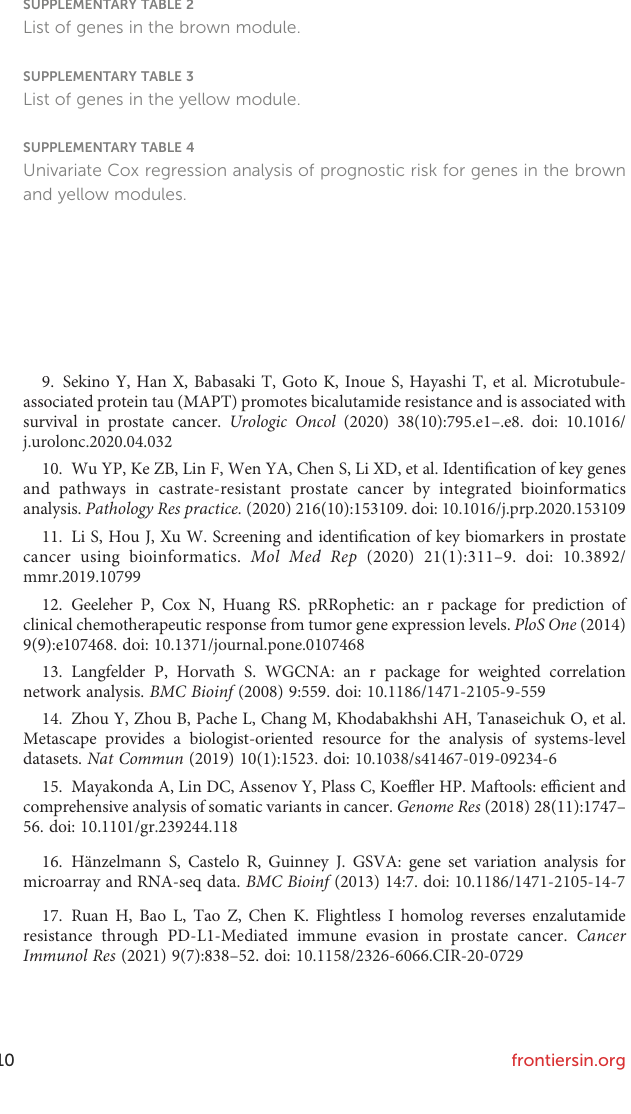
SUPPLEMENTARY TABLE 2 List of genes in the brown module. SUPPLEMENTARY TABLE 3 List of genes in the yellow module. SUPPLEMENTARY TABLE 4 Univariate Cox regression analysis of prognostic risk for genes in the brown and yellow